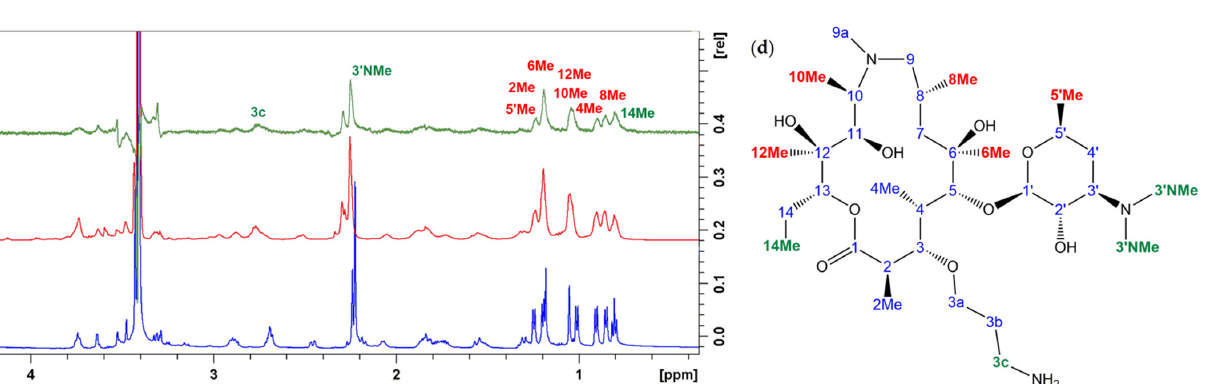
Figure 4. Free (blue) and bound-state (red) NOE cross peaks indicative of the folded-out conformation: ( a ) H4-H11; ( b ) H2-H4; and ( c ) H5-H6Me.